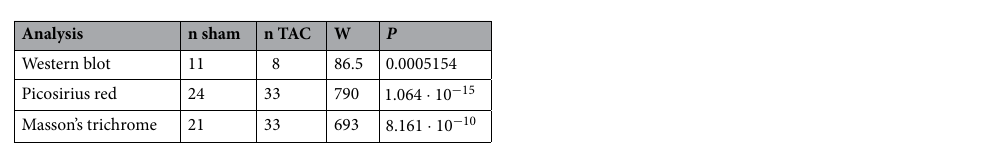
Table 1. Statistical analysis of differences between sham and TAC